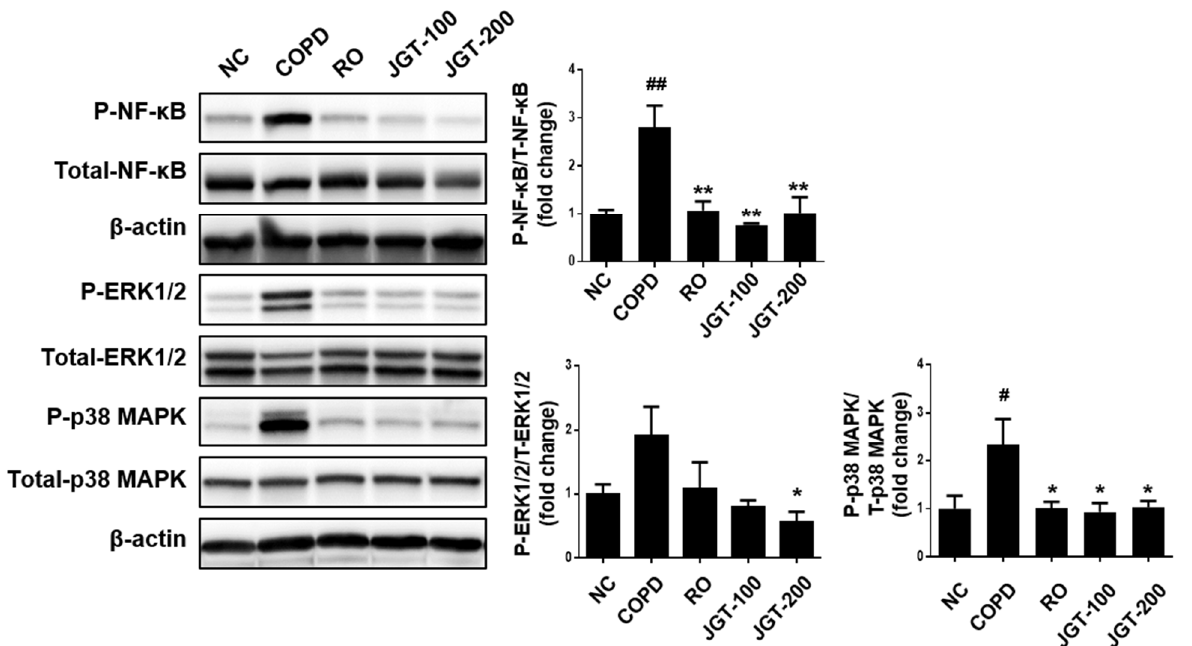
Figure 8. Effects of JGT on activations of NF- κ B, ERK1/2, and p-38 in lung tissues, according to Western blot analysis. NC, normal control mice; COPD, CS & LPS-treated mice; RO, roflumilast (5 mg/kg) along with CS & LPS-treated mice; JGT-100, JGT (100 mg/kg) along with CS & LPS-treated mice; JGT-200, JGT (200 mg/kg) along with CS & LPS-treated mice. Data are displayed as means ± SEM. # p < 0.05 and ## p < 0.01 compared with NC; * p < 0.05 and ** p < 0.01 compared with COPD.